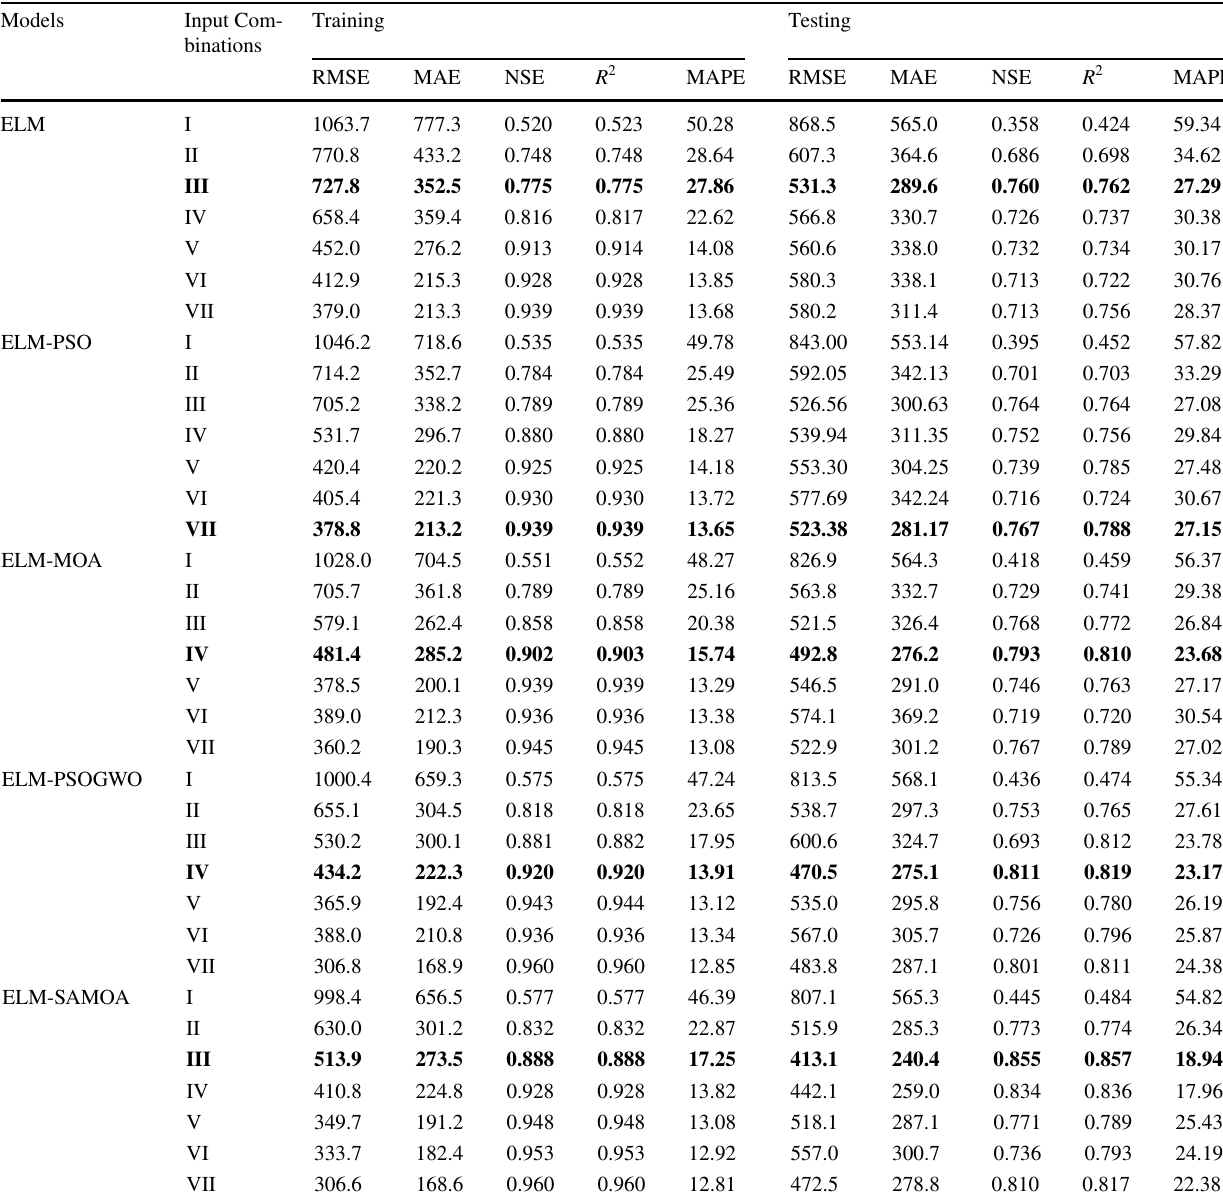
Table 4 The results of the single-phase, two-phase optimized and standalone ELM models in prediction streamflows of Gorai Station